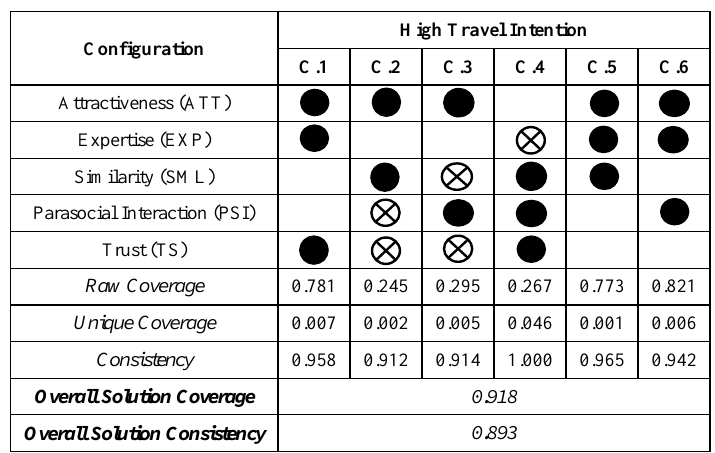
Table 11. fsQCA Results for High Travel